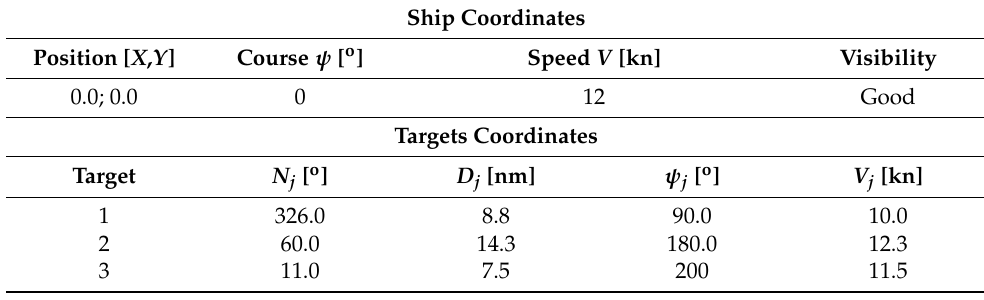
Table 5. Ship coordinates and targets coordinates (three targets).